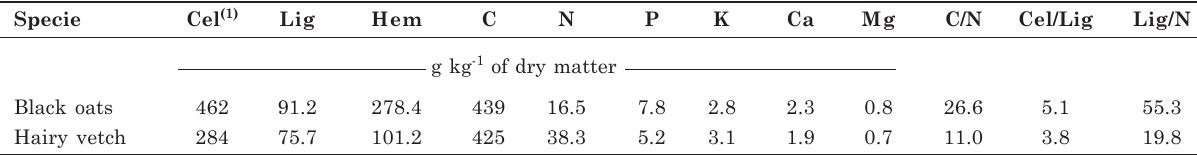
(1) Cel: cellulose; Hem: hemicellulose; Lig: